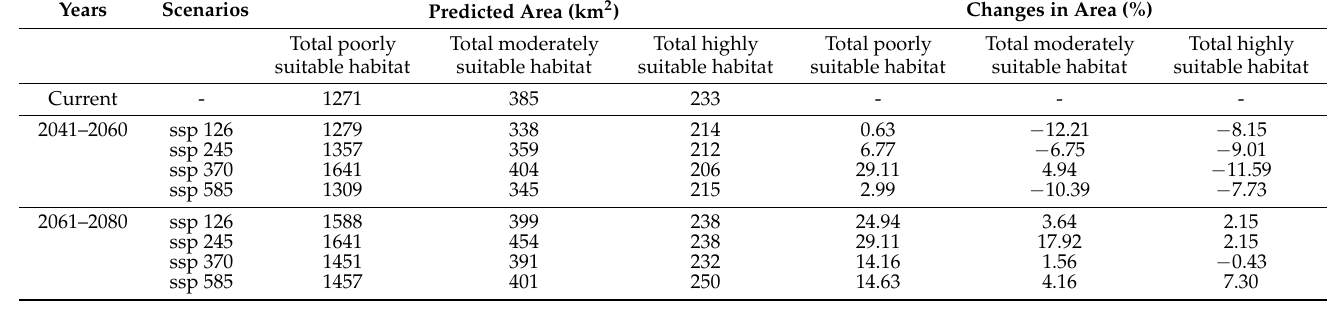
Table 4. Extent of predicted three different categories of suitable habitats (km 2 ) for Eurasian Pygmy Owl ( Glaucidium passerinum ) in current time, and in two periods: 2041–2060 and 2061–2080, in different climate scenarios (SSP 126, 245, 370, 585). Additionally, we calculated changes (%) from current time to future periods.